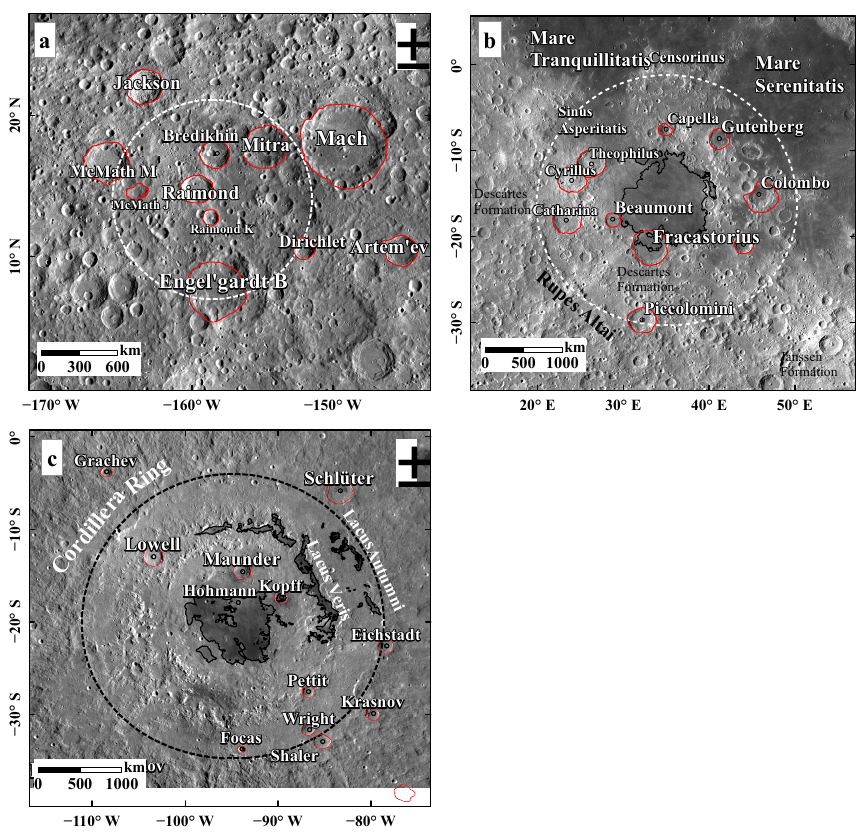
Figure 2. WAC images of the three basins in Mercator projection. ( a ) Map of Dirichlet–Jackson Basin centered at 158.2 ◦ W, 13.4 ◦ N. ( b ) Map of Nectaris Basin centered at 35.1 ◦ E, 15.6 ◦ S. ( c ) Map of Orientale Basin centered at 94.8 ◦ W, 20.1 ◦ S. The red lines show the craters labeled in the maps.